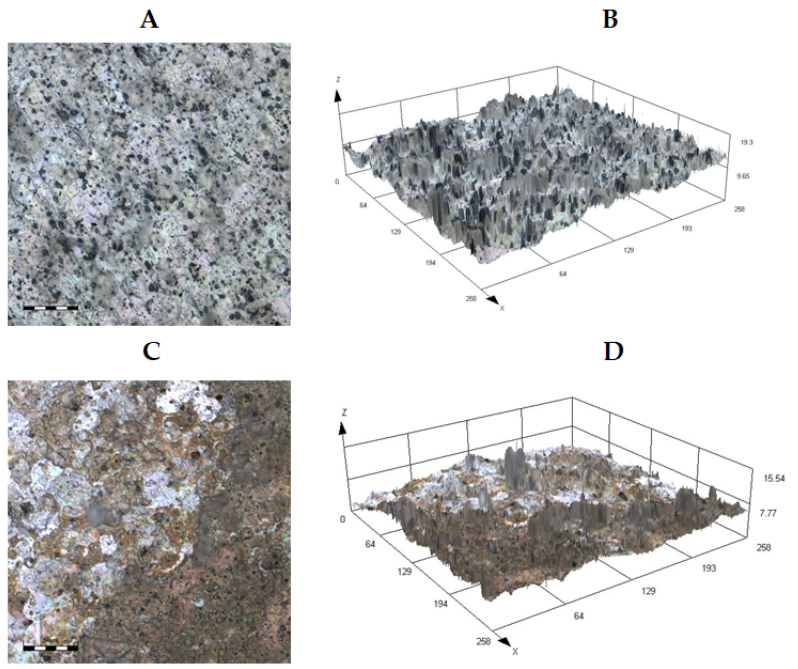
Figure 4. Micrographs of AMg6 alloy samples with the stearate coating applied: ( A , B )—before corrosion tests; ( C , D )—after corrosion tests.